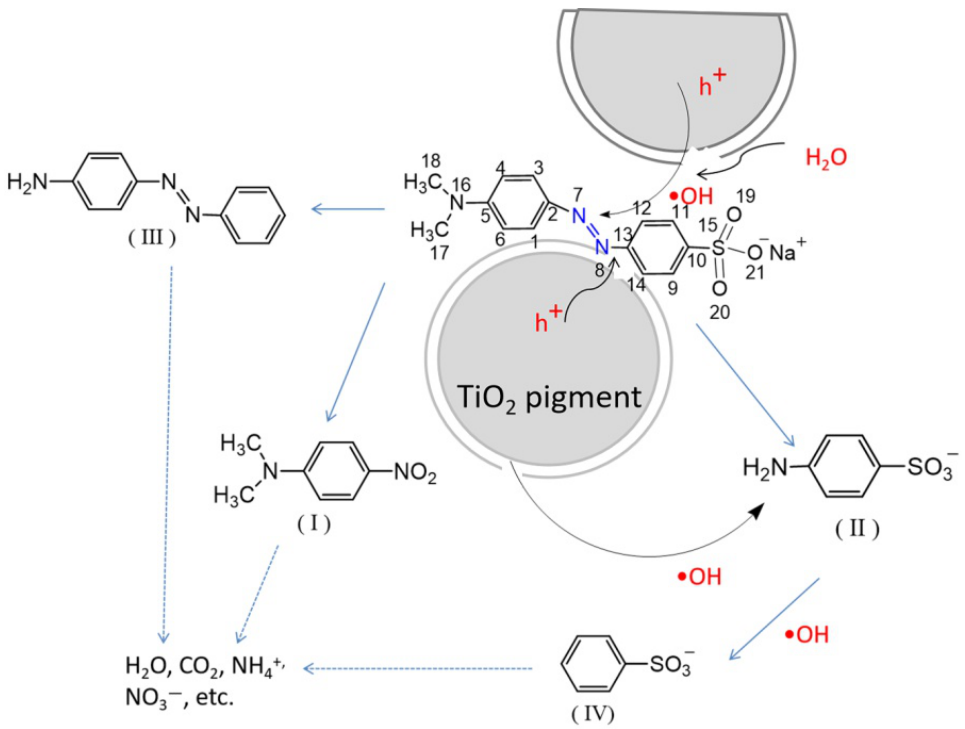
Figure 8. Proposed pathways of photodegradation of MO.